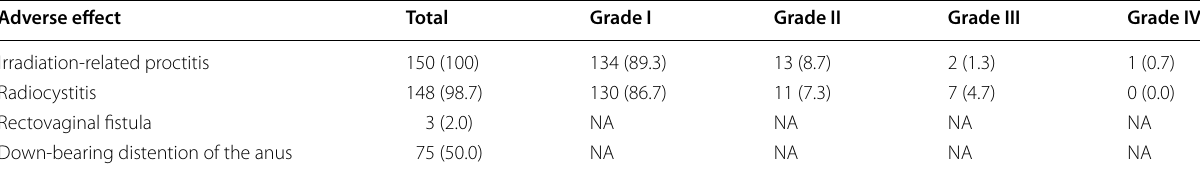
Table 4 Irradiation-related adverse effects in 150 patients with cervical cancer who were treated with californium-252 neutron brachytherapy combined with external-beam radiotherapy